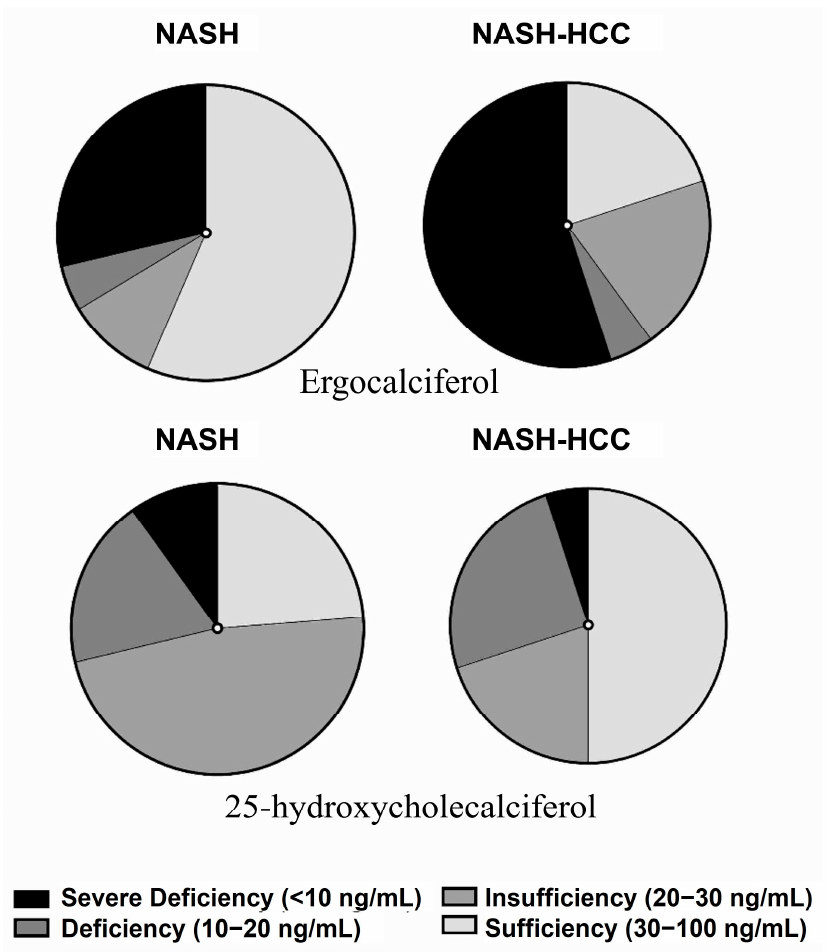
Figure 4. Segregation of ergocalciferol and 25-Hydroxycholecalciferol in the NASH-HCC patients when compared to NASH patients.